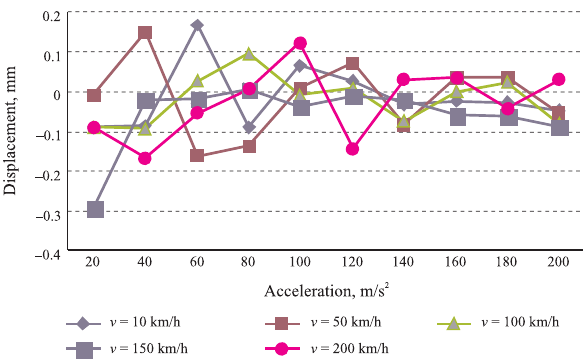
Fig. 6. Max displacement of the plate with different accelerations and fixed